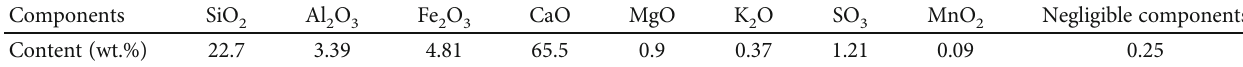
Table 1: Chemical composition of grade G oil-well cement.